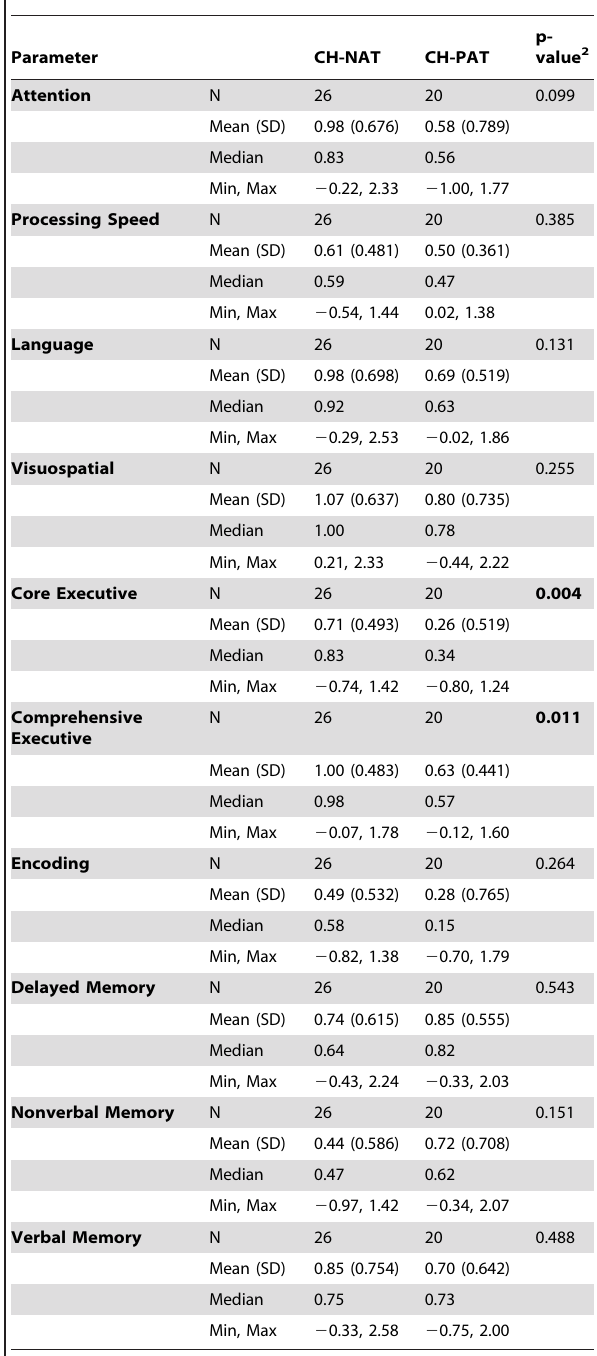
Table 4. Cognitive domains (composite z scores) in the cognitively healthy study population 1 .